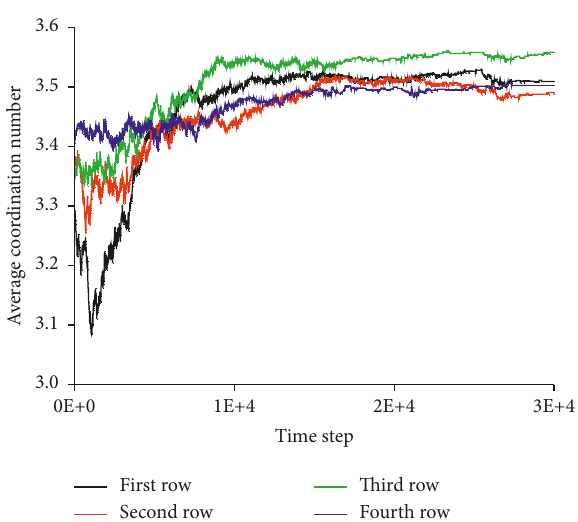
Figure 23: Coordination number below the